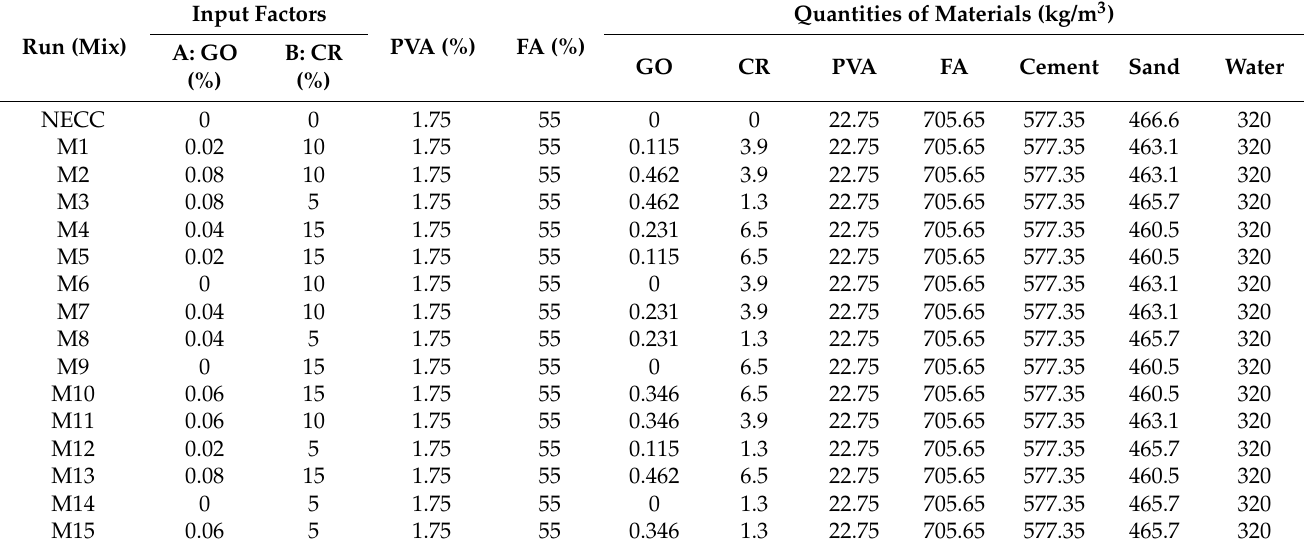
Table 1. RSM generated runs, and the proportions materials.